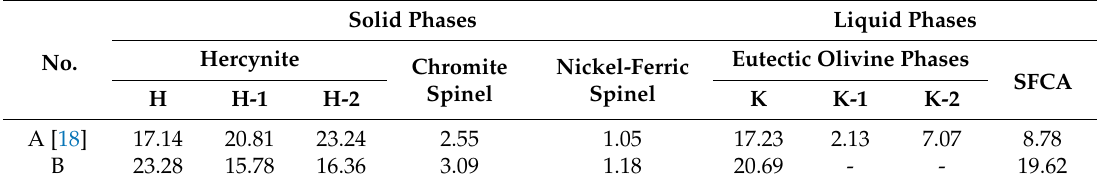
Table 6. Mineral compositions of product sinter of di ff erent sintering processes (area-%).